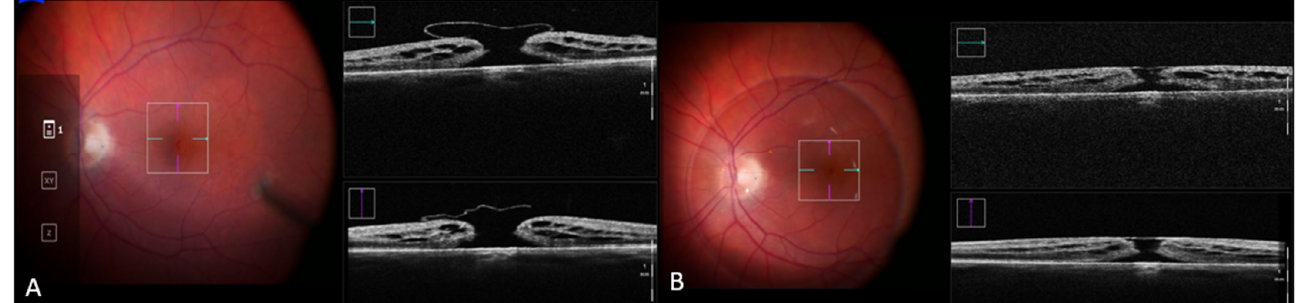
Figure 2. A ppearance of an FTMH on iOCT after ILM peeling and inverted flap before ( A ) and after ( B ) PFCL injection viewed through a horizontal (green arrow) and vertical (purple arrow) cross- section. Notice that the ILM flap flattens after PFCL injection and that the diameter of the FTMH is reduced. Abbreviations: FTMH, full-thickness macular hole; iOCT, intraoperative optical coherence tomography; ILM, internal limiting membrane; PFCL, perfluorocarbon liquid.